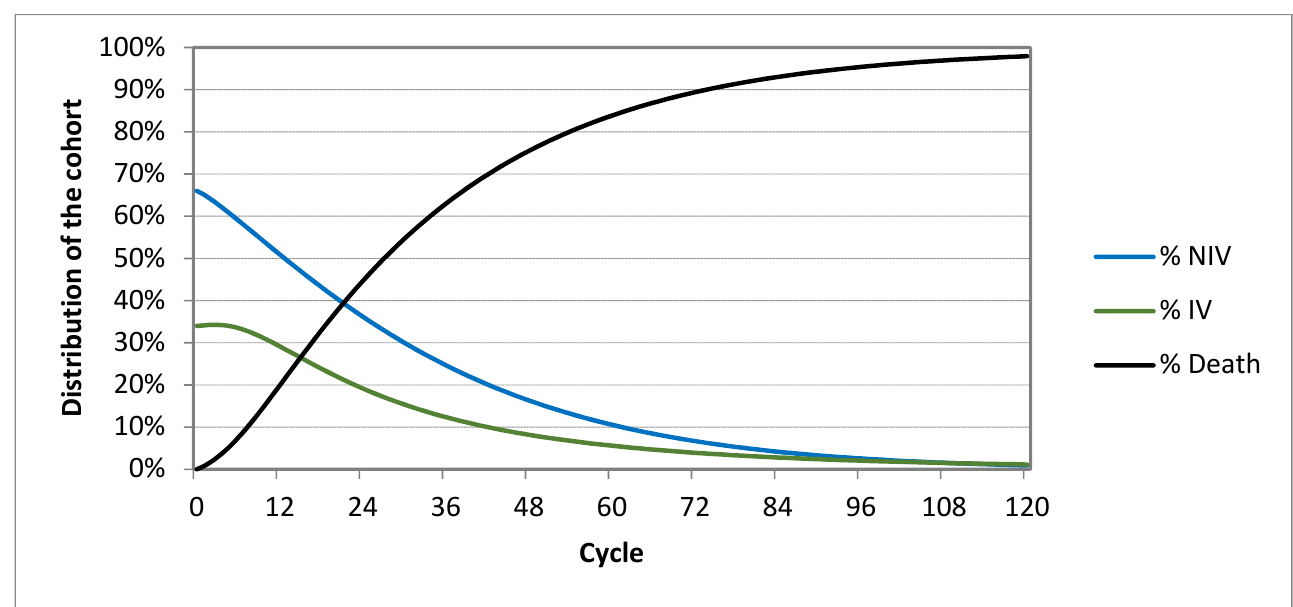
Figure 2. Distribution of cohort in individual cycles of home mechanical ventilation (“HMV“).